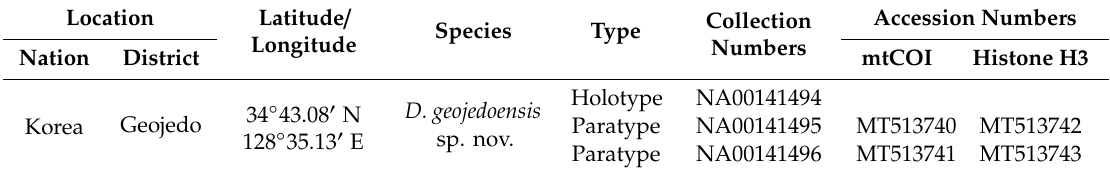
Table 1. List of sampling localities, species name, specimen type, Marine Biodiversity Institute of Korea (MABIK) collection numbers, and GenBank accession